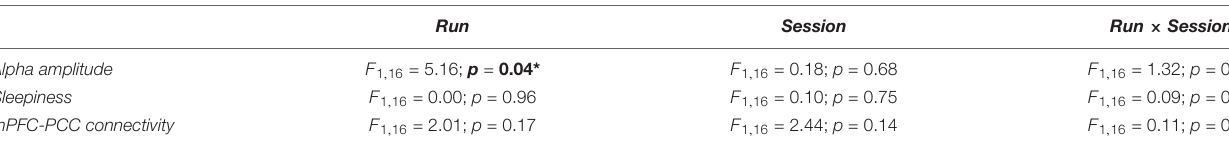
FIGURE 3 | Values averaged over all subjects for pre and post of (A) alpha amplitude, (B) self-rated sleepiness, and (C) mPFC-PCC connectivity strength. A two-way ANOVA was calculated for each of the measurements, with the factors session ( tACS , sham ) and run ( pre , post ). (D–F) Show individual and averaged changes from pre to post separately for each session. TABLE 1 | Results of the